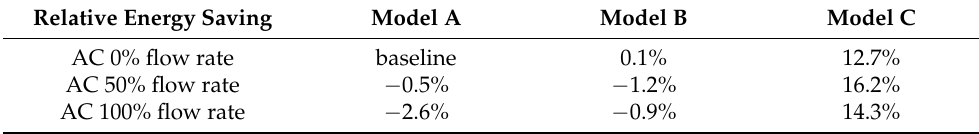
Table 6. Relative energy savings for different geometry models and AC flow